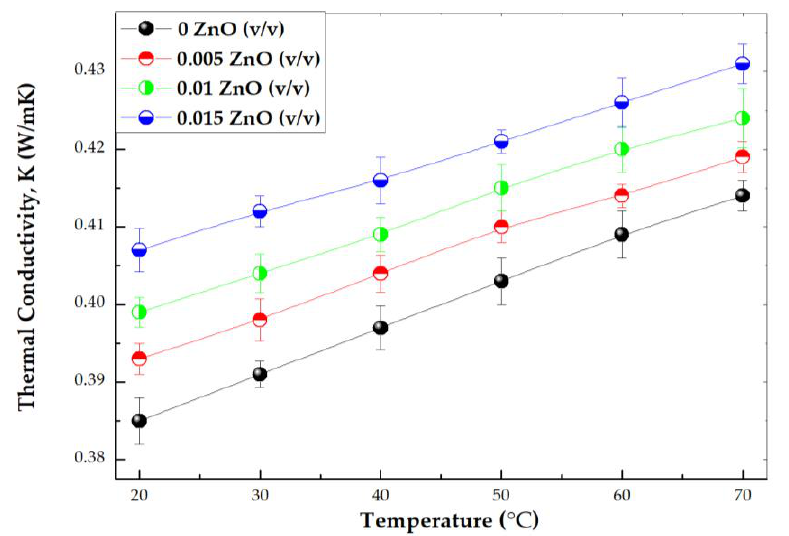
Figure 12 . Experimental thermal conductivity vs. temperature of 40:60 PG/W-based ZnO nanoflu-